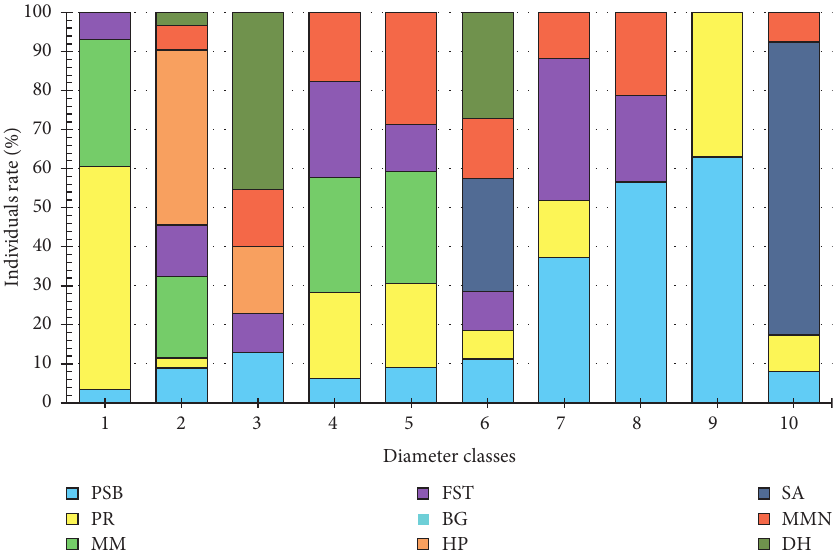
Figure 4: Diametric structure of trees in green spaces in Brazzaville. Prefecture garden (HP), Saint-Anne garden (SA), Blanche Gomes garden (BG), Marien Ngouabi Museum garden (MMN), Ministry of Mines square (MM), Pierre Savorgnon De Brazza garden (PSB), Rotary Club square (PR), Faculty of Science and Technology square (FST), and Human rights square (DH).